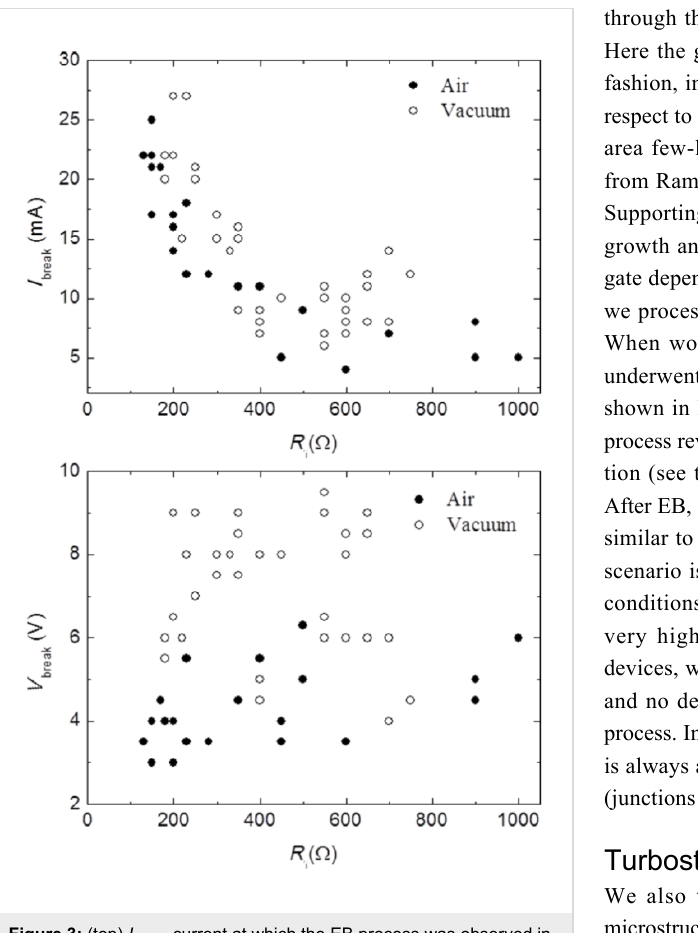
Figure 3: (top) I break current at which the EB process was observed in air (filled dots) and under vacuum (open circles) as a function of the initial resistance of the device. (bottom) Corresponding V break